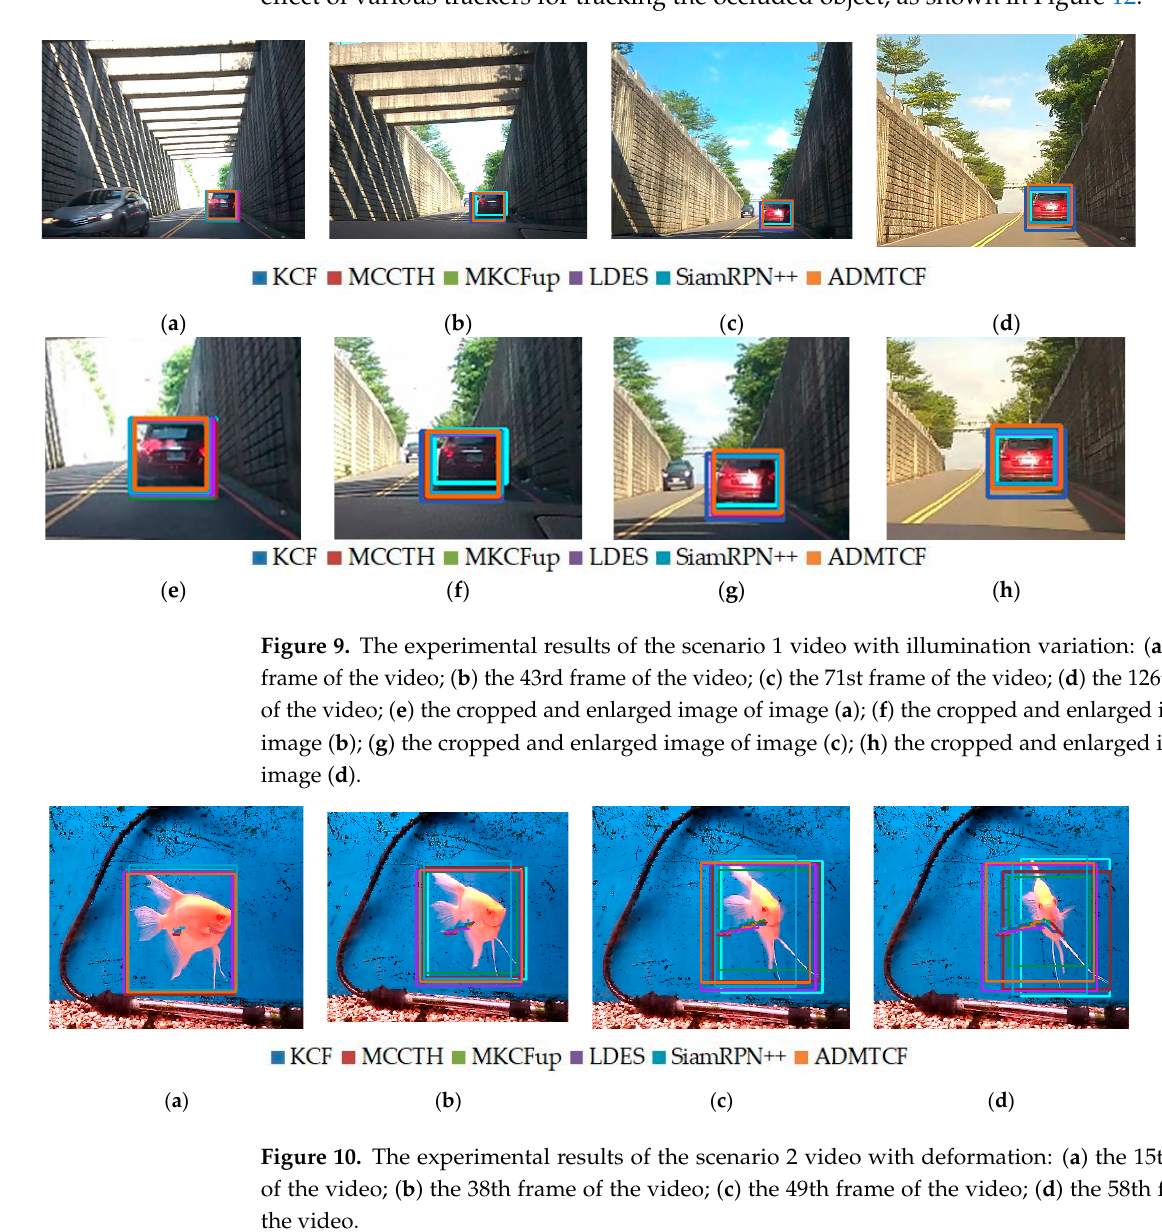
( h ) Figure 11. The experimental results of the scenario 3 video with motion blur: ( a ) the 1st frame of the video; ( b ) the 15th frame of the video; ( c ) the 31st frame of the video; ( d ) the 46th frame of the video; ( e ) the cropped and enlarged image of image ( a ); ( f ) the cropped and enlarged image of image ( b ); ( g ) the cropped and enlarged image of image ( c ); ( h ) the cropped and enlarged image of image ( d ).